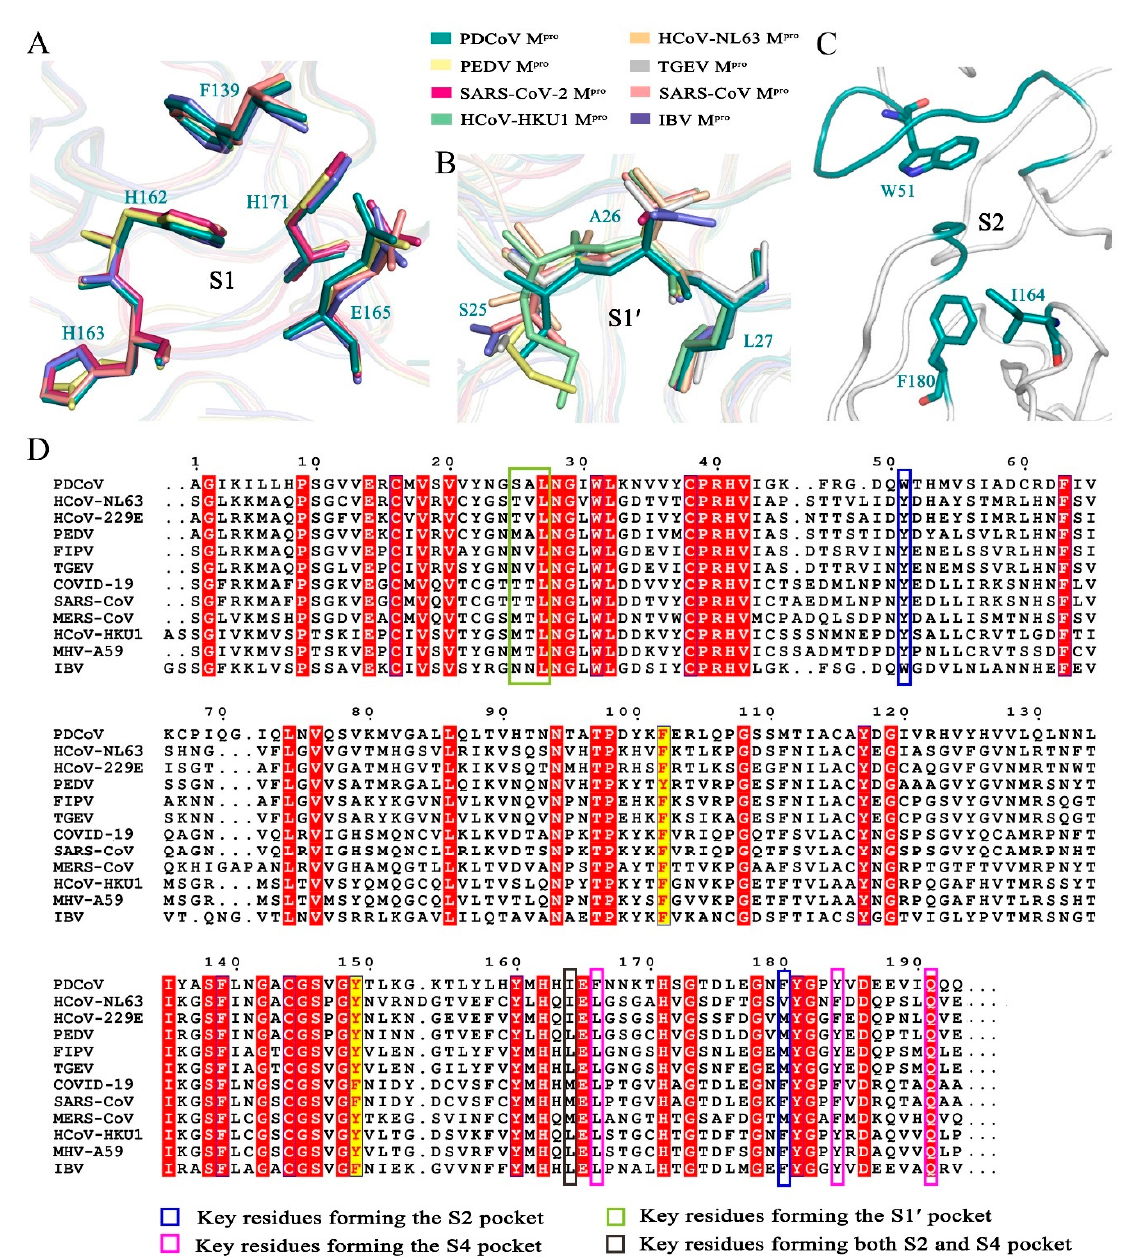
Figure 2. Analysis of the substrate-binding pocket of PDCoV M pro . ( A ) Superimposition of the key residues in the S1 binding pockets of PDCoV M pro (deep teal), PEDV M pro (pale yellow), SARS-CoV M pro (salmon) and IBV M pro (slate). ( B ) Superimposition of the key residues in the S1 ′ binding pocket of PDCoV M pro (deep teal), HCoV-HKU1 M pro (pale green), HCoV-NL63 M pro (light orange), PEDV M pro (pale yellow), SARS-CoV-2 M pro (warm pink), SARS-CoV M pro (salmon), TGEV M pro (silver) and IBV M pro (slate). ( C ) Hydrophobic residues in the S2 binding pocket. ( D ) Sequence alignment of the M pro domains I and II from four different genera. PDCoV from Deltacoronavirus ; HCoV-NL63, PEDV, FIPV, TGEV from Alphacoronavirus ; SARS-CoV-2, SARS-CoV, MERS-CoV, HCoV-HKU1, MHV- A59 from Betacoronavirus ; IBV from Gammacoronavirus . A sequence alignment was generated using the program ClustalW and drawn by ESPript3. White letters with red backgrounds show identical residues, and red letters with yellow backgrounds show conservative